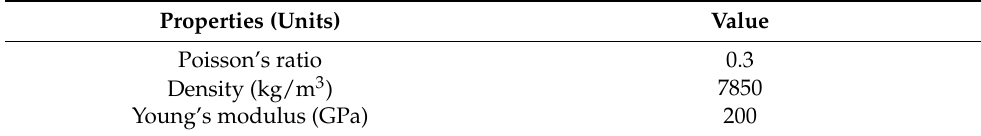
Table 2. Properties of the tool material [16].